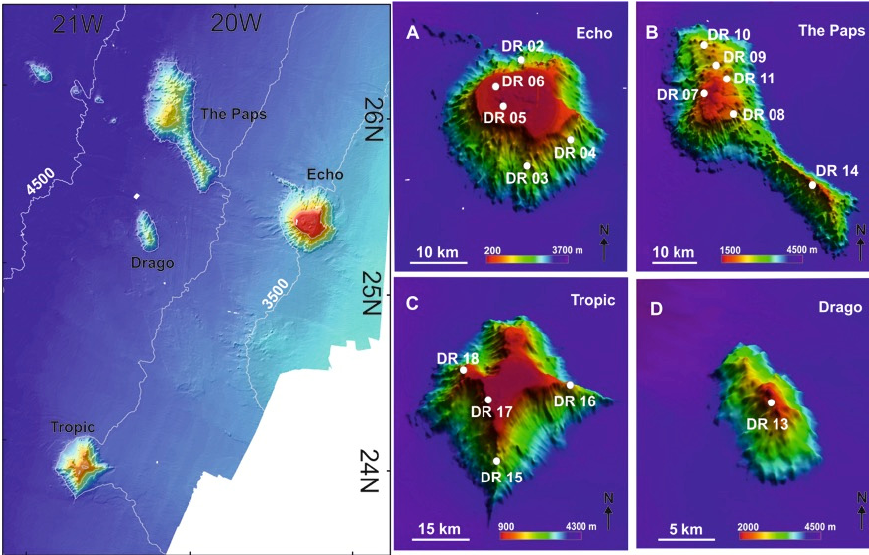
Figure 10. Location of the studied seamounts in the southwestern part of the Canary Islands Seamount Province (CISP) including the positions of the benthic dredge samples (DR) in ( A ): Echo Seamount; ( B ): The Paps Seamount; ( C ): Tropic Seamount; ( D ): Drago Seamount. See Supplementary Table S2. and fragile deep-sea gorgonians ( Metallogorgia melanotrichos, Chrysogorgia, Paramuricea ) (Figure 11F–H), bamboo corals, and small soft corals ( Anthomasthus ), hexactinellid sponges ( Aphrocallistes ), together with crustaceans ( Munidopsis ) and echinoderms that are generally attached to the gorgonians (mainly the ophiuroids Ophiocreas and Asteroschema, as well as Antedonidae crinoids). The ferromanganese crust substrate of the northern flank of this seamount (DR10, 2839 — 3010 mbsl in Figure 10B) is colonized by hexactinellid sponges, gorgonians ( M. melanotrichos ) and echinoderms (brisingid and goniasterid star- fishes, Figure 11I,J , ophiuroids on the gorgonians, e.g., Ophiocreas and Asteroschema ).